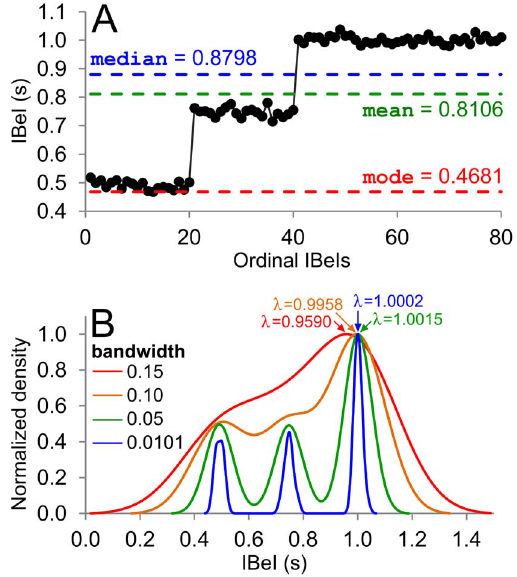
Figure 1. Illustrating different central tendency statistics. (A) A hypothetical IBeI series comprised of three distinct tempo sections: 20 IBeIs with a mean of 0.5 s (i.e., 120 bpm), followed by 20 IBeIs with a mean of 0.75 s (80 bpm), followed by 40 IBeIs with a mean of 1.00 s (60 bpm). The mean, median, and mode of the data fail to provide an adequate measure of central tendency. (B) Kernel density estimation (KDE) of the distribution of IBeI values inFigure 1A, using various bandwidth values. The most accurate measure of central tendency was obtained using adaptive Gaussian KDE [90,91].